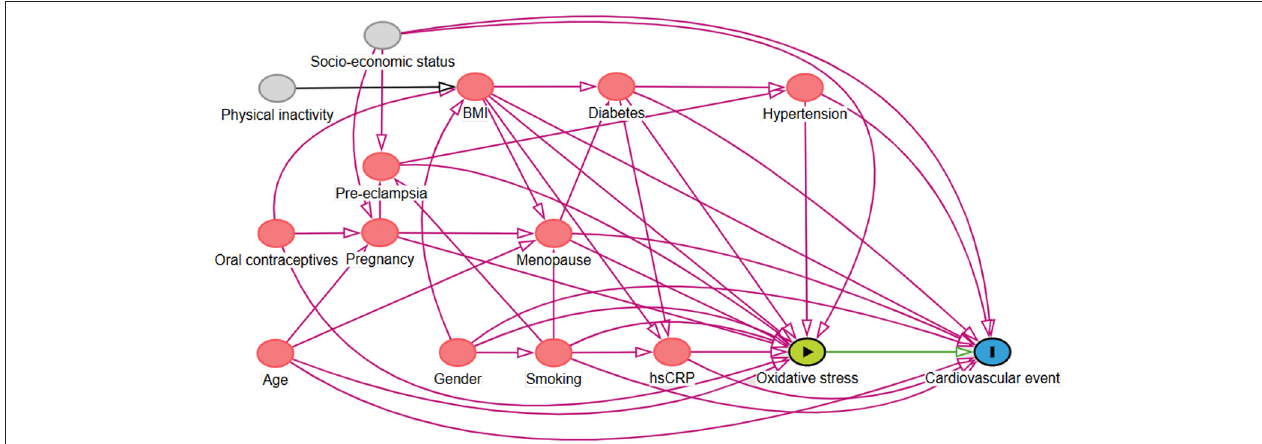
FIGURE 1 | Directed Acyclic Graph (DAG) demonstrating the causal paths hypothesized to be underlying the relationship between serum free thiols, representing systemic oxidative stress, and the risk of cardiovascular (CV) events. Following from this graph, several confounders were accounted for in the Cox proportional hazards regression